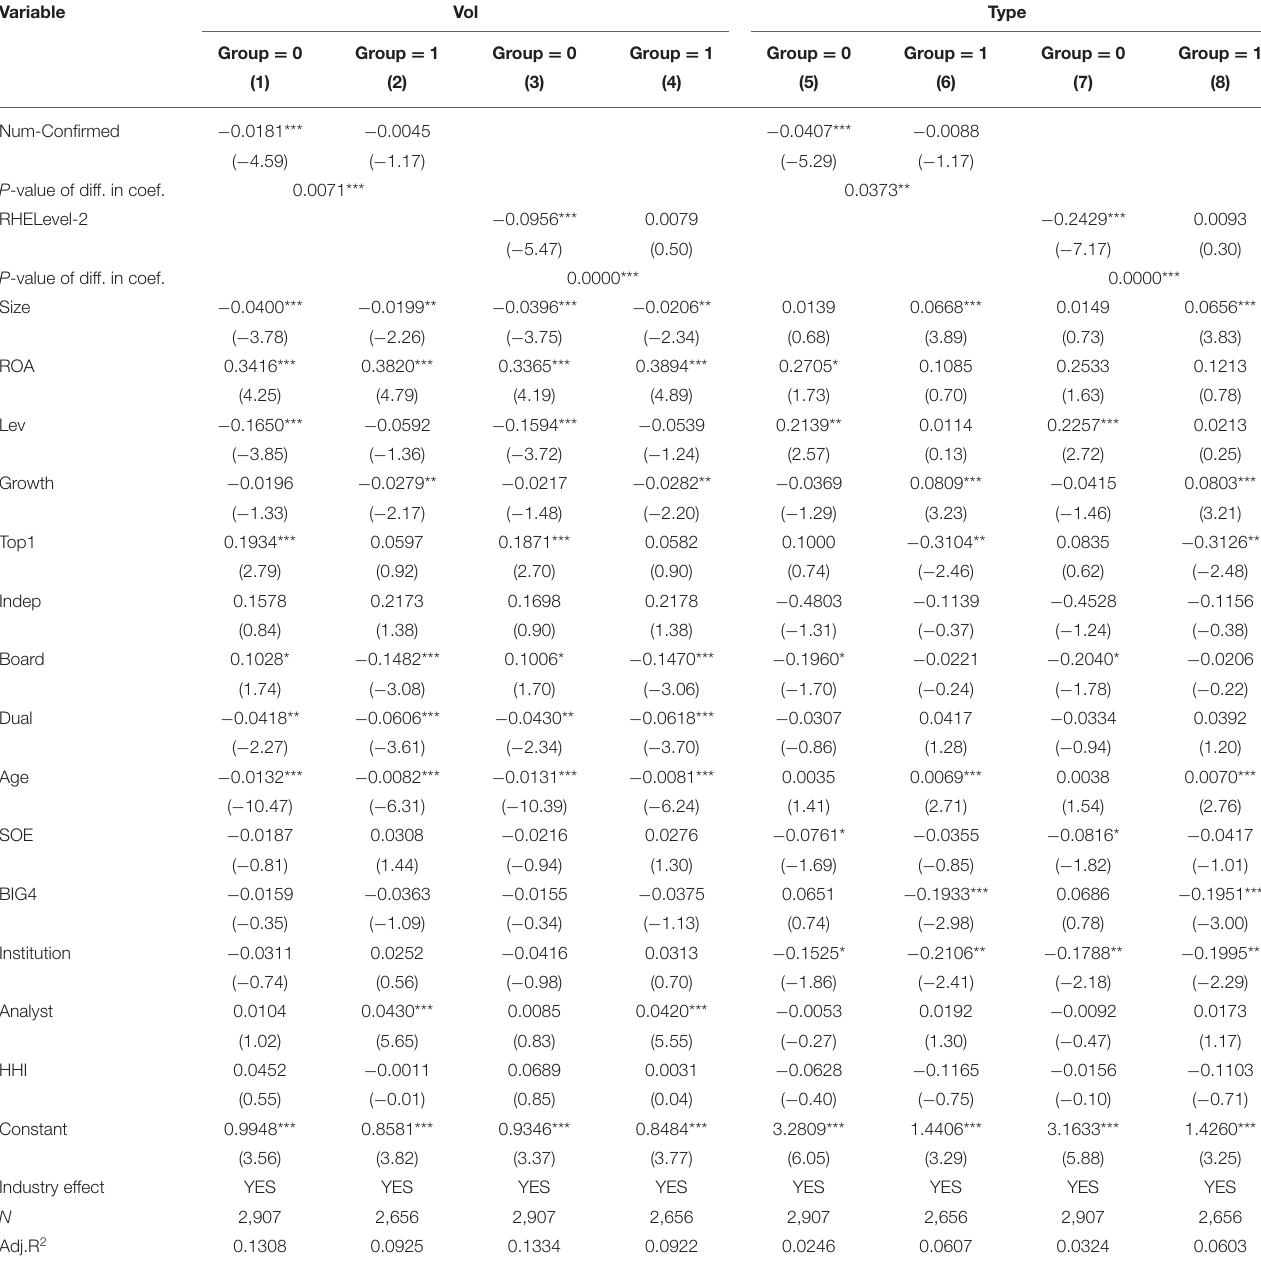
TABLE 15 | Impact of COVID-19 and media scrutiny on management earnings